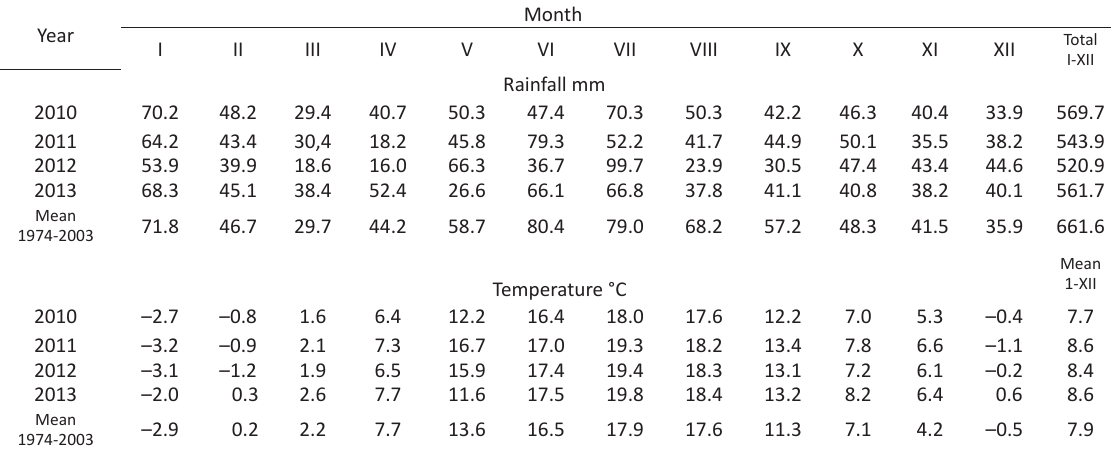
Table 1. Rainfall and air temperature in 2010-2013 as compared to the long-term mean figures (1974-2003) in